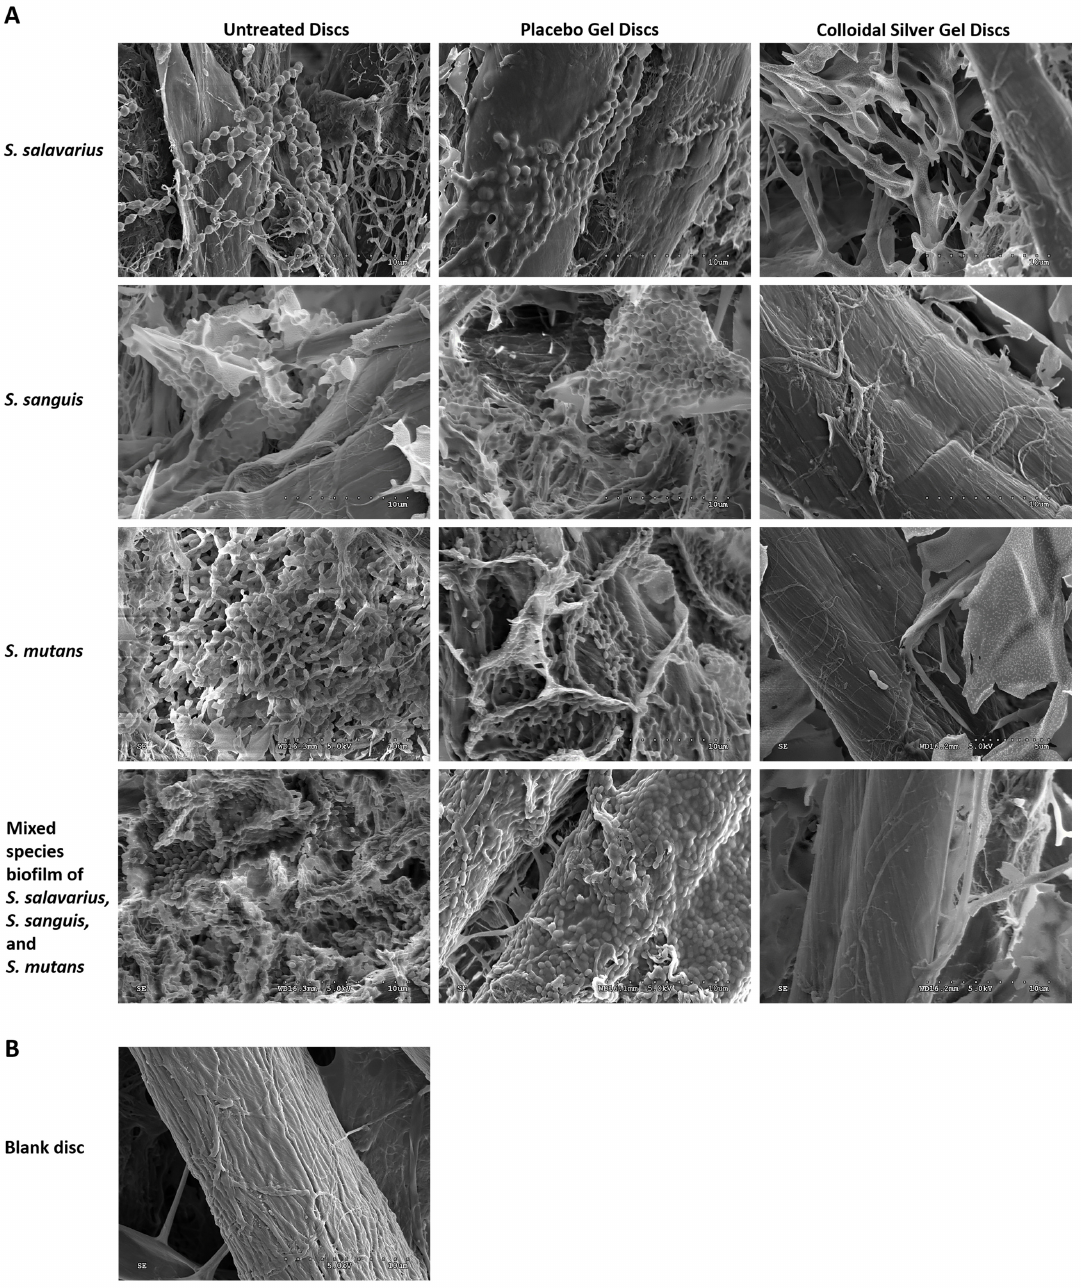
Figure 2. Scanning electron microscopy (SEM) imaging. ( A ) SEM analysis of S. salivarius, S. sanguis or S. mutans biofilm formation on untreated discs, discs treated with placebo gel or discs treated with colloidal silver gel. ( B ) SEM of a blank